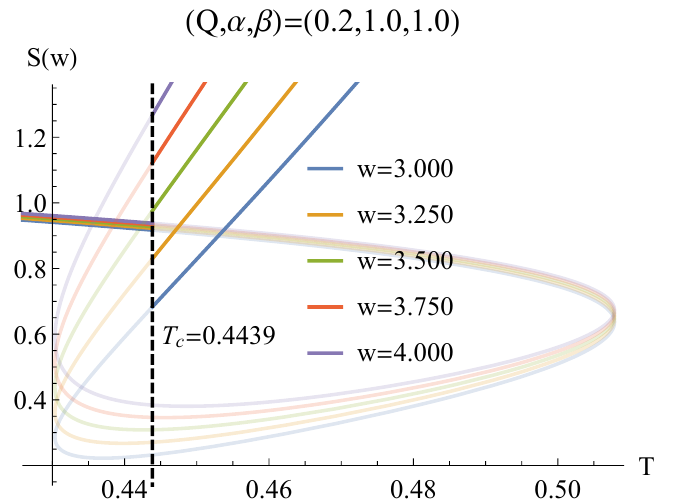
Figure 4 . HEE vs. T at several large widths specified by the plot legends, where the lighter segments correspond to the metastable regions. The black dashed vertical line represents the critical temperature T c = 0 . 4439 of the first-order phase transition. For each solid curve, the segments with lighter color are the unstable